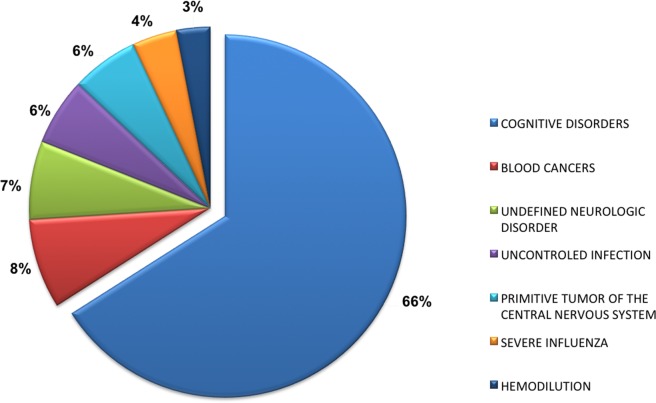
The medical contraindications that allowed procurement in the research group.Note that cognitive disorders, first source of targeted corneas for research, include any neurodegenerative disease (such as Alzheimer, Parkinson disease, Multiple Sclerosis, Amyotrophic lateral sclerosis…). These diseases represent contraindications for corneal procurement and transplantation, to ensure safety of the graft: the principle is to rule out any degenerative disease presumed to be transmissible via corneal transplantation. These contraindications follow a precautionary principle.